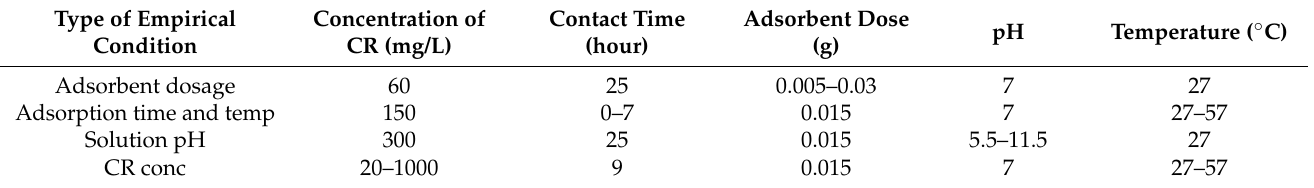
Table 1. Empirical circumstances of